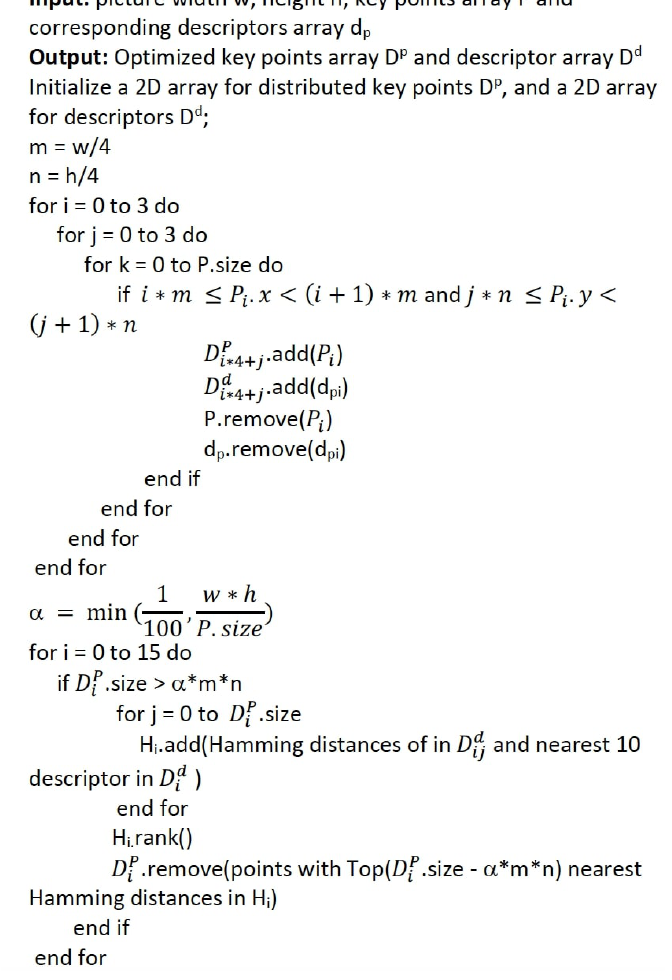
Figure 10. Algorithm for Reducing Feature